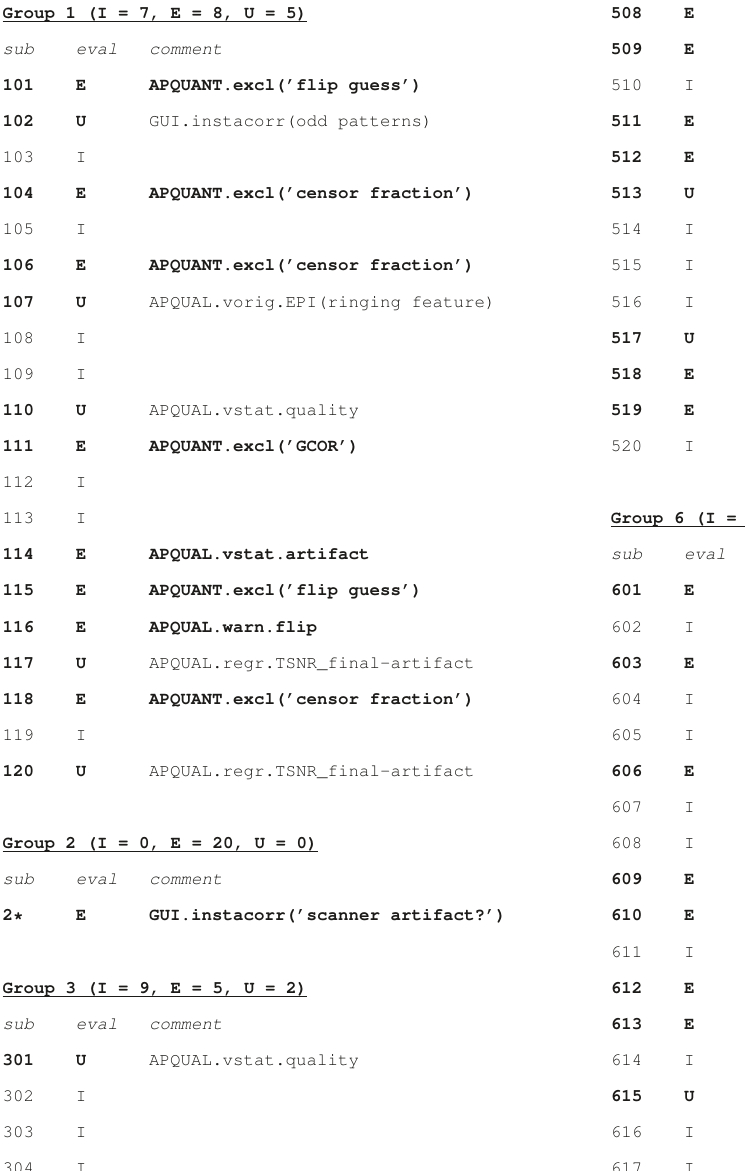
TABLE 3 A brief summary of resting state FMRI dataset evaluations, based on the APQUANT, APQUAL and GUI QC checks. QC evaluations (brief): Groups 1-7 (resting state FMRI) Group 1 (I = 7, E = 8, U =